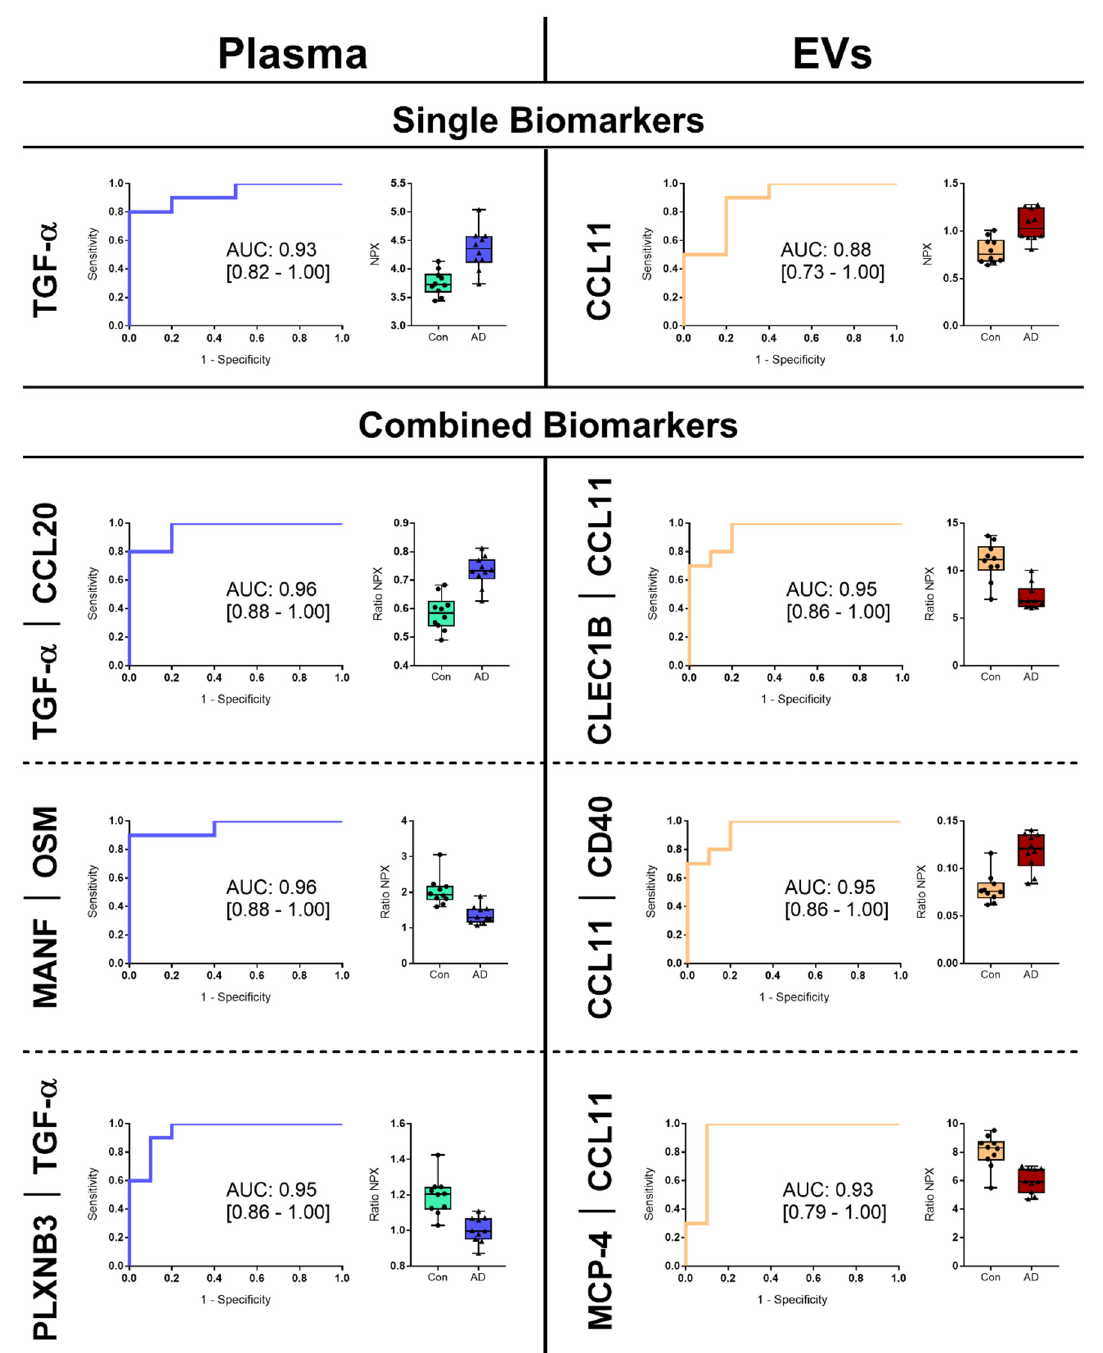
Figure 4. Receiver operating characteristic curves for single proteins with false discovery rate (FDR) correction, as well as top three protein ratios of proteins with high covariance found with partial least squared discriminant analysis (PLSDA), both for plasma and EVs. Area under the curves and 95% CI are presented for each receiver operating characteristic (ROC) curve, comparing healthy controls and AD patients. Box plots show the Normalized Protein Expression (NPX) and ratio NPX values for single or combined biomarker candidates comparing controls and AD